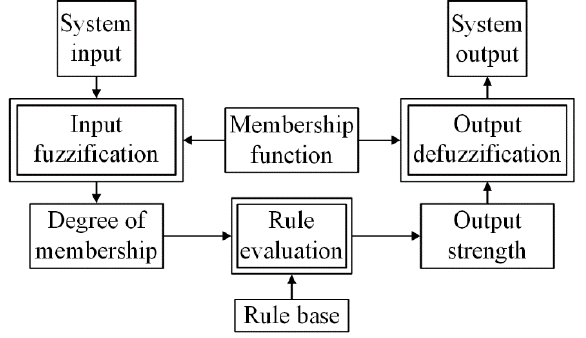
Figure 6. Data flow of the fuzzy logic control.